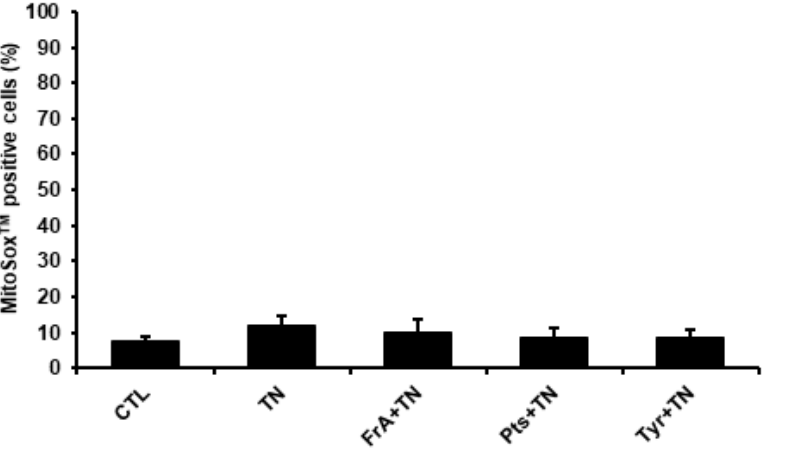
Figure 6. The antioxidant activity of ferulic acid, pterostilbene, and tyrosol do not seem to directly account for their cardioprotective effects. H9c2 cells were pre-treated for 1 h with ferulic acid (FrA, 5 µ M), pterostilbene (Pts, 0.5 µ M), or tyrosol (Tyr, 1 µ M) and then treated for 24 h with tunicamycin (TN, 10 µ g/mL). Accumulation of the mitochondrial superoxide anion O 2 − was measured by flow cytometry using the MitoSOX TM Red probe. Values represent mean ± S.E.M. ( n =